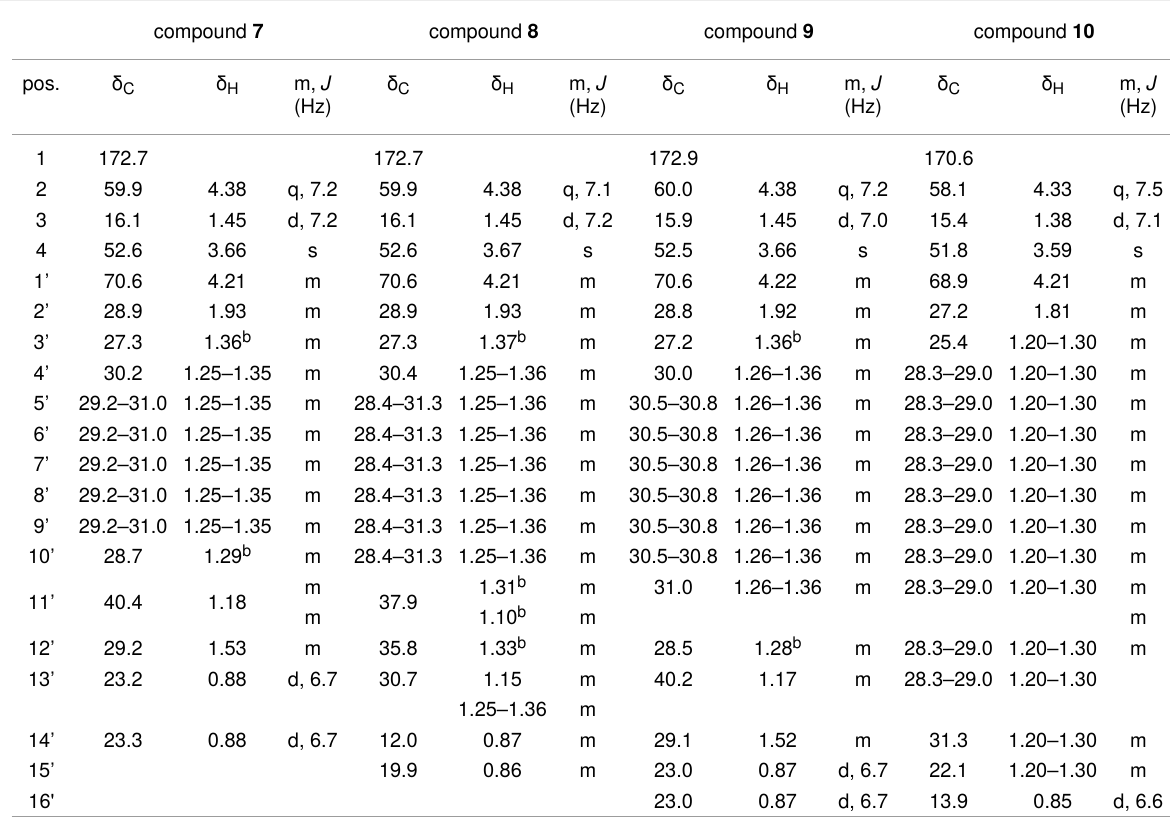
Table 1: 1 H (500 MHz) and 13 C (125 MHz) NMR data for azodyrecin D ( 7 ), azodyrecin E ( 8 ), azodyrecin F ( 9 ), and azodyrecin G ( 10 ). a